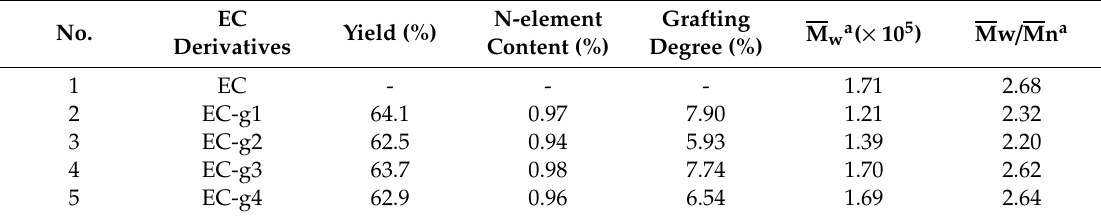
Table 1. Molecular weight, yield and grafting degree of pure ethyl cellulose and grafted with ethyl cellulose.